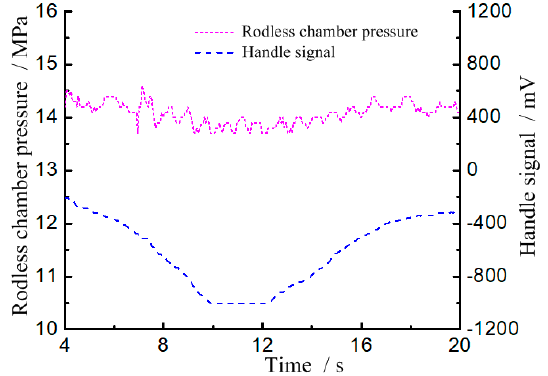
Figure 13. Curves of the rodless pressure and speed.